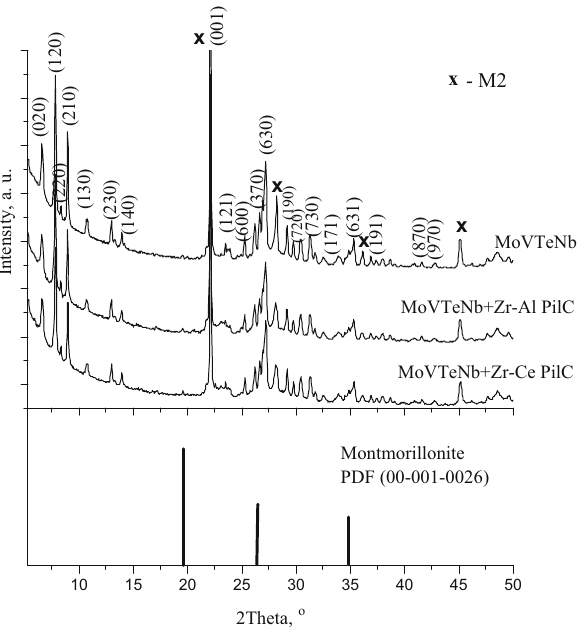
Figure 1: Di ff raction patterns of Zr – Ce - , Zr – Ca - , and Zr – Al - pillared clays.